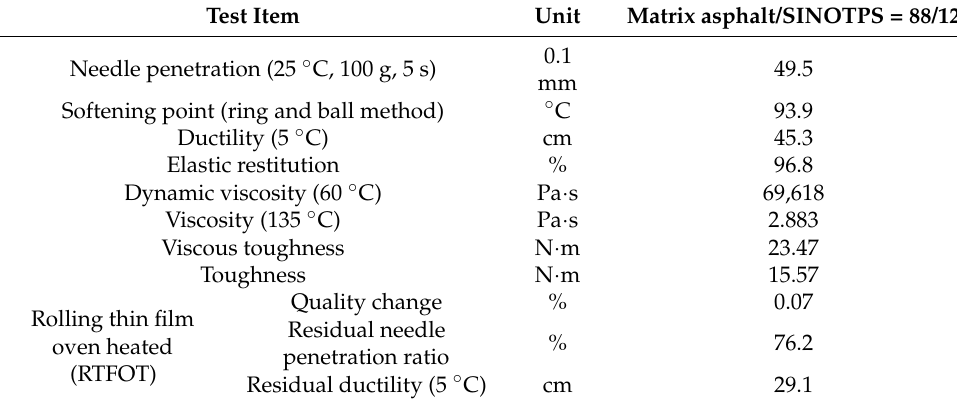
Table 8. Technical indicators of modified asphalt (12% SINOTPS).